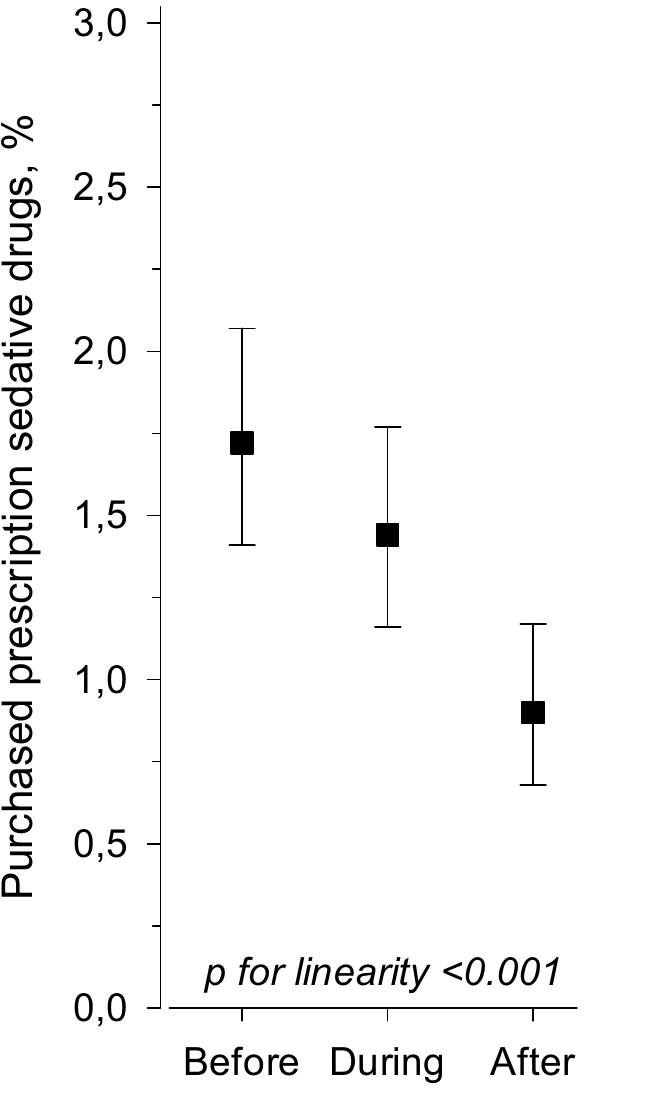
Figure 1. Percentage of the primiparous women who purchased prescription sedative drugs within 90 days before conception, during pregnancy or within 90 days after delivery. Prescription drug purchase with Anatomical Therapeutic Chemical (ATC) codes N03AE (clonazepam), N05BA (benzodiazepine derivatives anxiolytics), N05CD (benzodiazepine derivates), or N05CF (benzodiazepine related drugs) were considered as sedative drugs. Whiskers represents 95% confidence